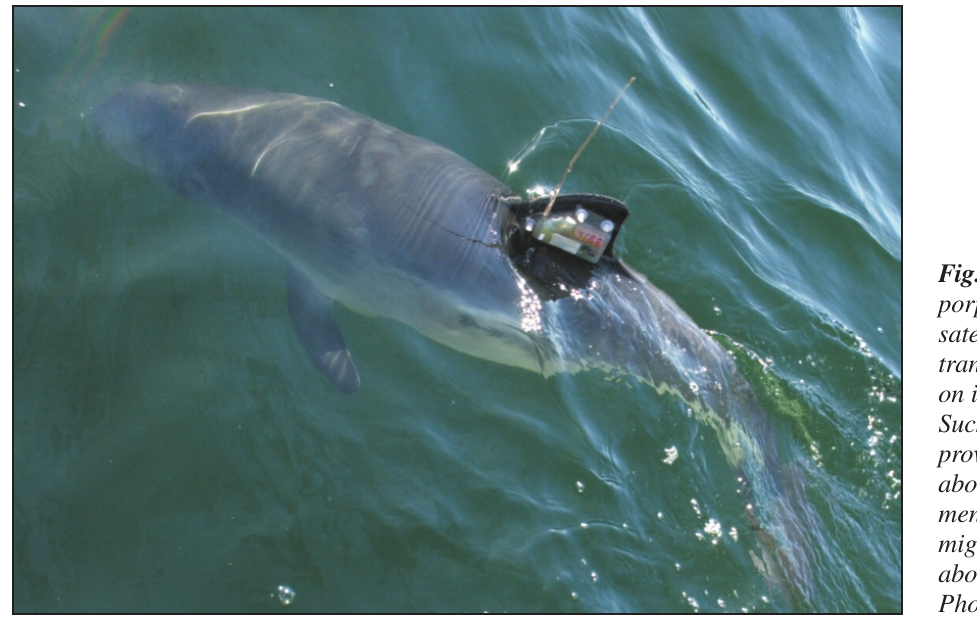
Fig. 2 . A harbour porpoise with a satellite-linked radio transmitter mounted on its dorsal fin. Such applications provide information about local move- ments and seasonal migrations, and about habitat use. Photo: J.